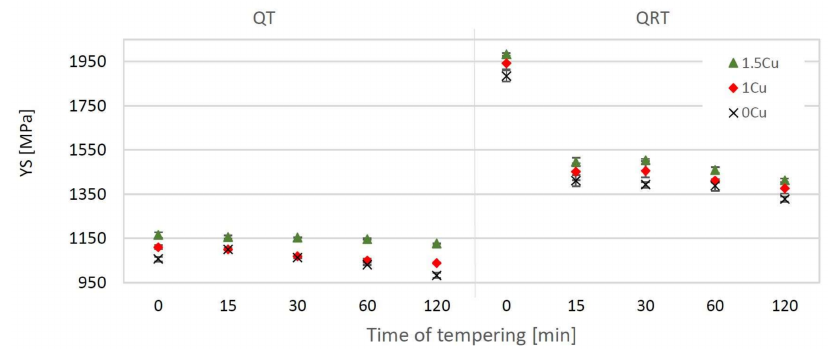
Figure 2. Yield stress after di ff erent times of tempering at 400 ◦ C for 0, 15, 30, 60, and 120 min.